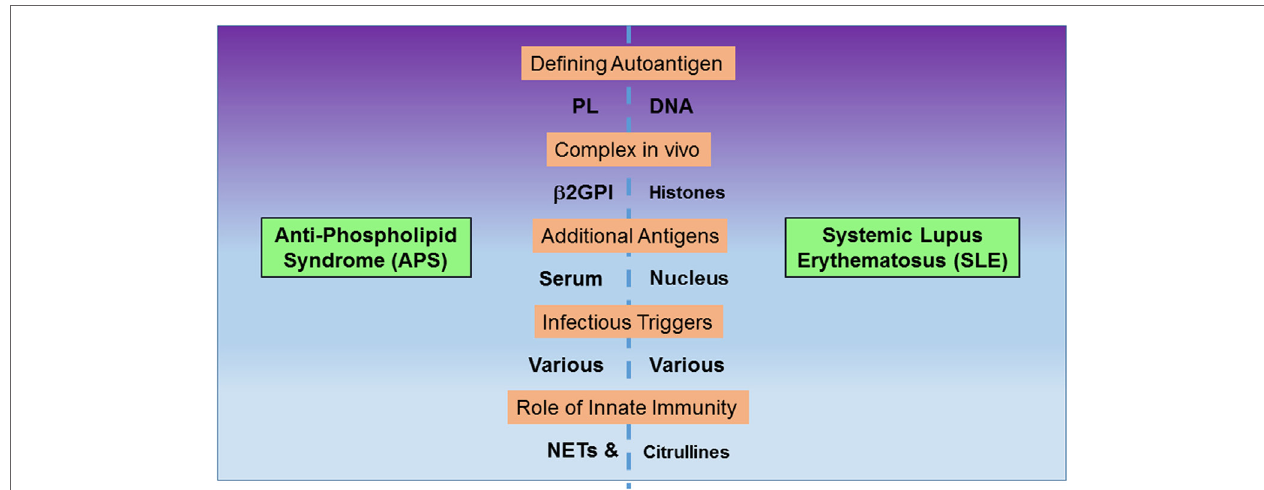
FigURe 1 | Comparison of features between anti-phospholipid syndrome (APS) and systemic lupus erythematosus (SLE). The two autoimmune disorders exhibit autoantibodies to negatively charged, non-protein antigens, phospholipids (PL), and DNA. However, autoantibodies also recognize complexes between PL and β 2GPI or DNA and histones, respectively. Additional autoantibody targets include other serum proteins in APS and nuclear proteins in SLE. Both disorders are potentially triggered by infections, and innate immunity contributes to pathogenesis, as neutrophil extracellular traps (NETs) form integral components of thrombi in vivo and citrullinated histones are prominent anti-citrullinated protein